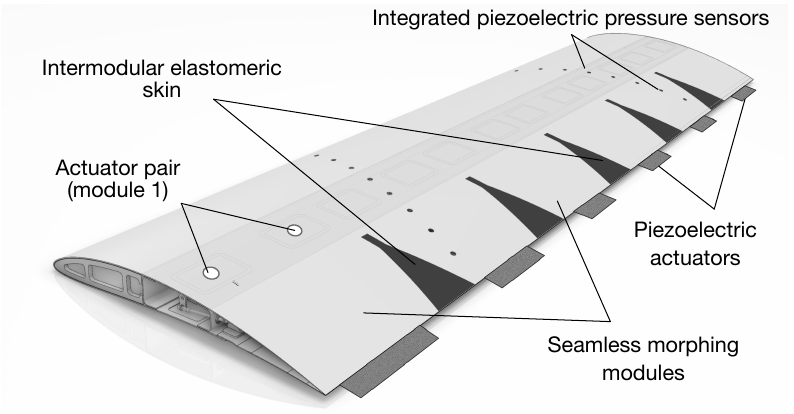
Figure 10. SmartX-Alpha sensor hardware integration.